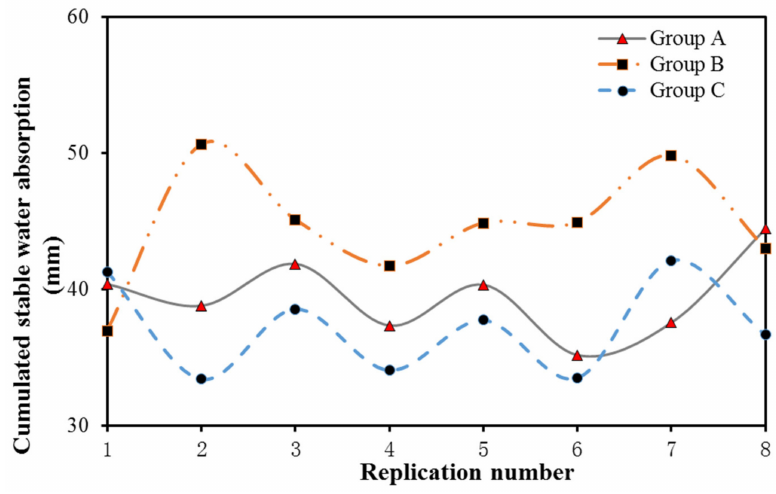
Figure 4. Stable water absorption of composite soils under di ff erent design rainfall